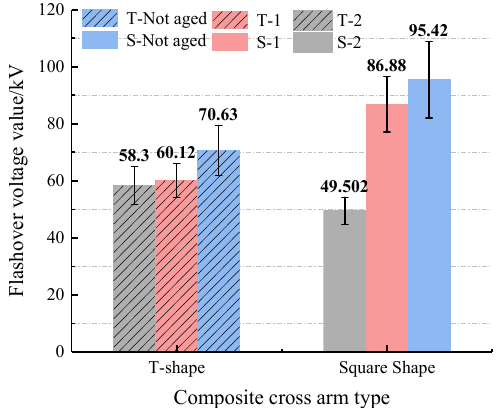
Figure 5. Multi-factor aging composite cross-arm flashover voltage.